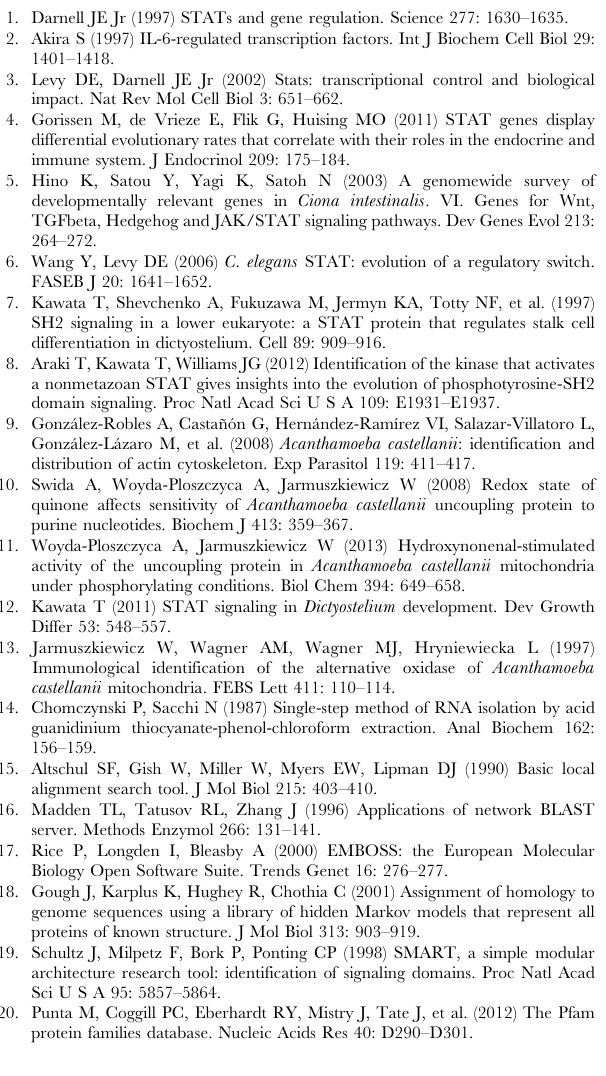
Figure S4 Molecular phylogenetic analysis by Maxi- mum Likelihood method of 59 STAT proteins